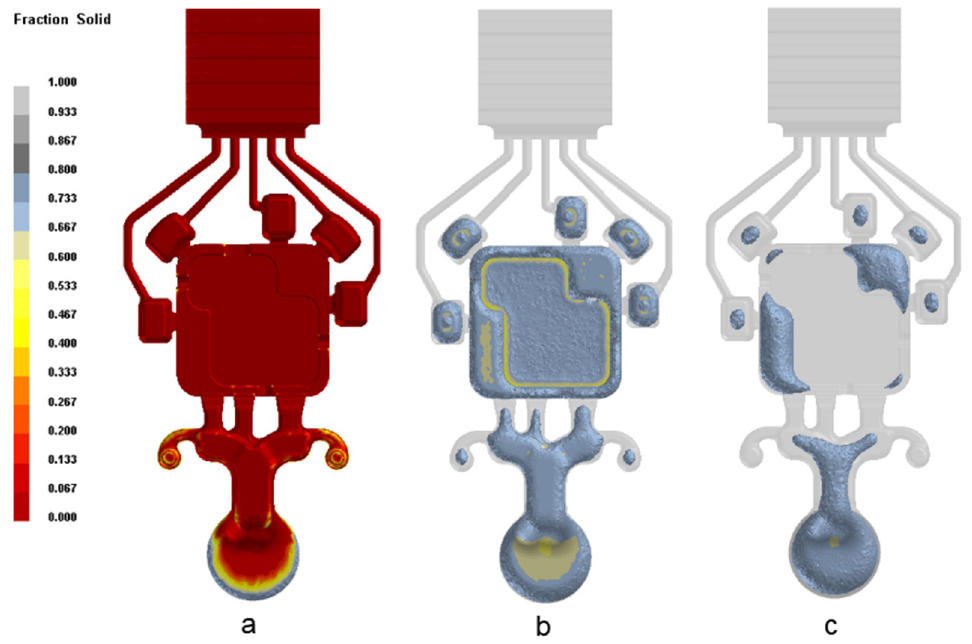
Figure 9. Solidification process of the die casting: ( a ) just beginning to solidify, ts = 0 s; ( b ) ingate solidified, ts = 2.1 s; and ( c ) hot spots position, ts = 4.3 s.